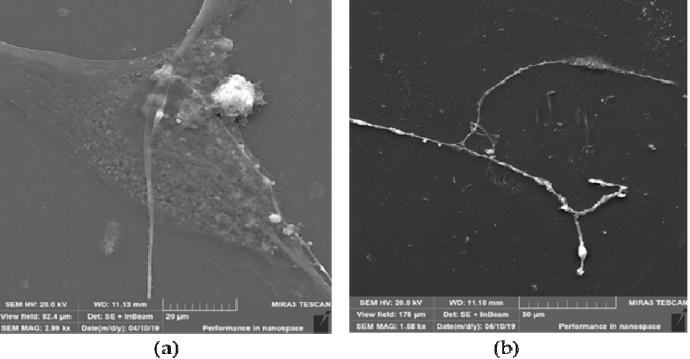
Figure 12. SEM of SCAP grown on graphene film. ( a ) Triangular cell body with arising long-distance membrane projections; ( b ) Slender cell projections synapsing with adjacent cell.